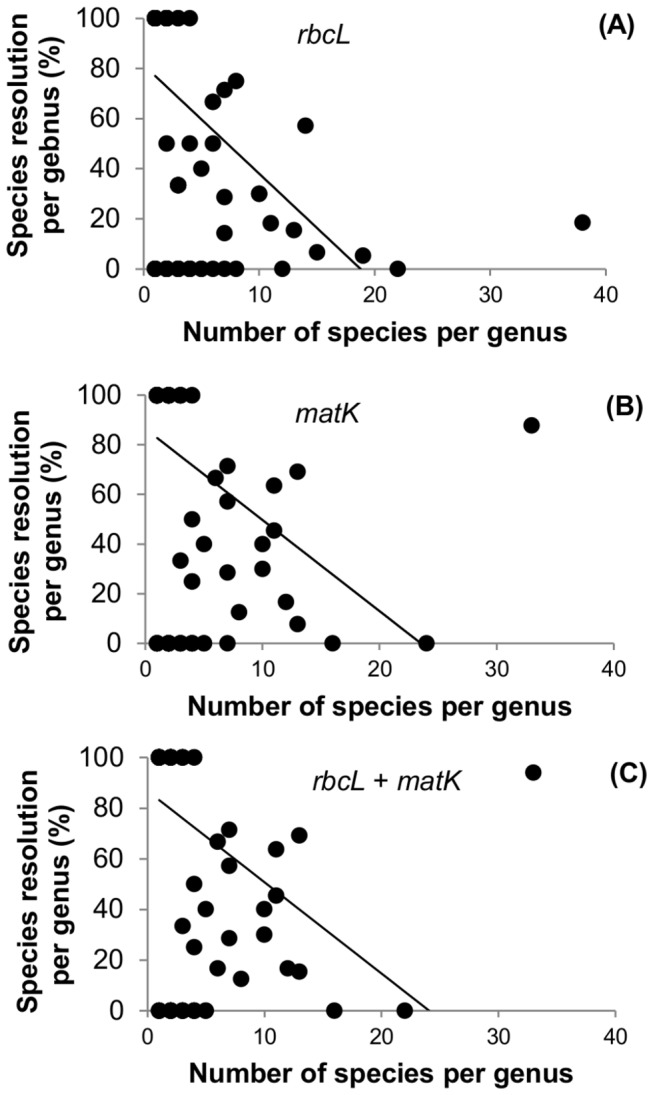
Scatterplots of the number of species sampled in each genus against the percentage of species resolved in each genus with rbcL, matK, and rbcL + matK.A. rbcL-175 genera (Pearson correlation coefficient r = 0.4180, n = 175, P < 0.0001), R2 = 0.1747. B. matK-159 genera (Pearson correlation coefficient r = 0.3685, n = 159, P < 0.0001), R2 = 0.1358. C. rbcL + matK-153 genera (Pearson correlation coefficient r = 0.3636, n = 153, P < 0.0001), R2 = 0.1322. Species resolution was scored in neighbour joining trees generated from uncorrected p-distances calculated from single-family alignments.